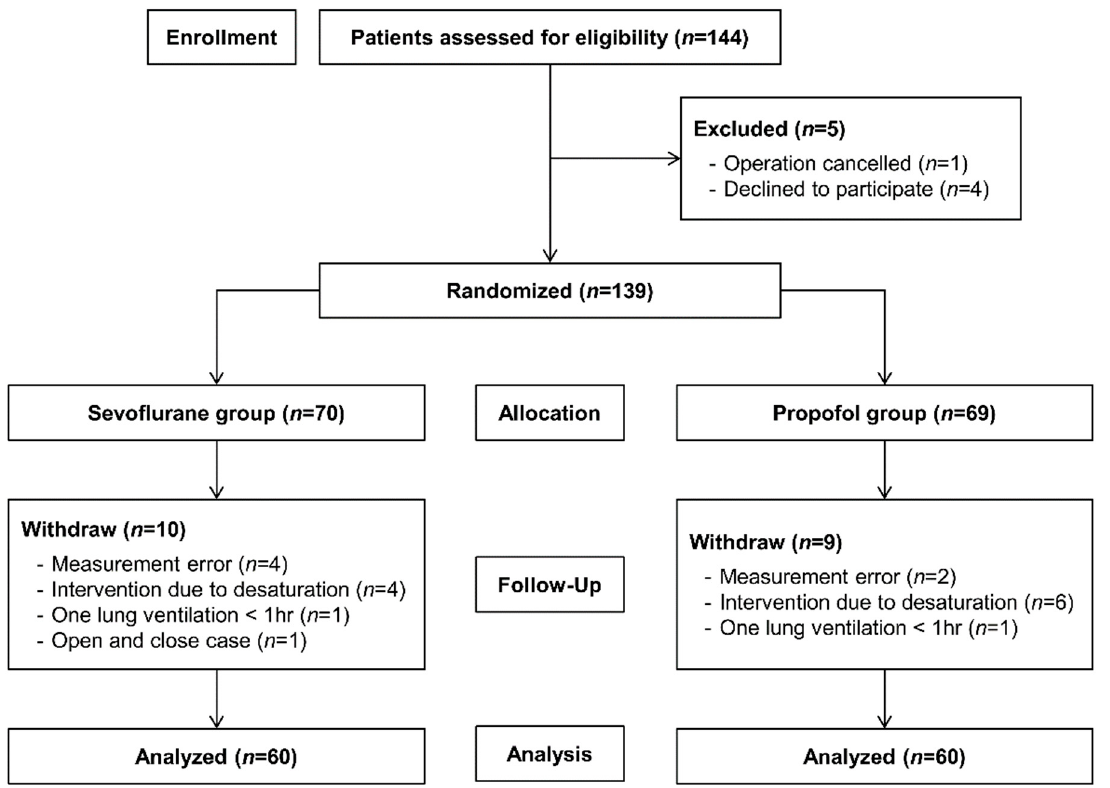
Figure 1. Flow diagram of patient selection.